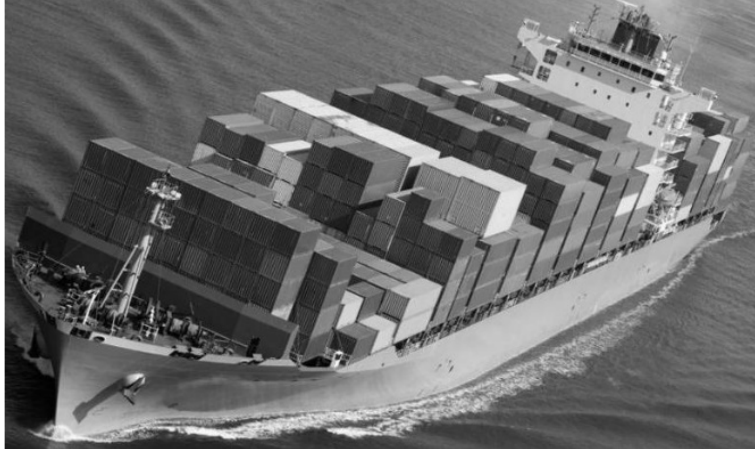
Figure 4. Gamma compression image of the ship.